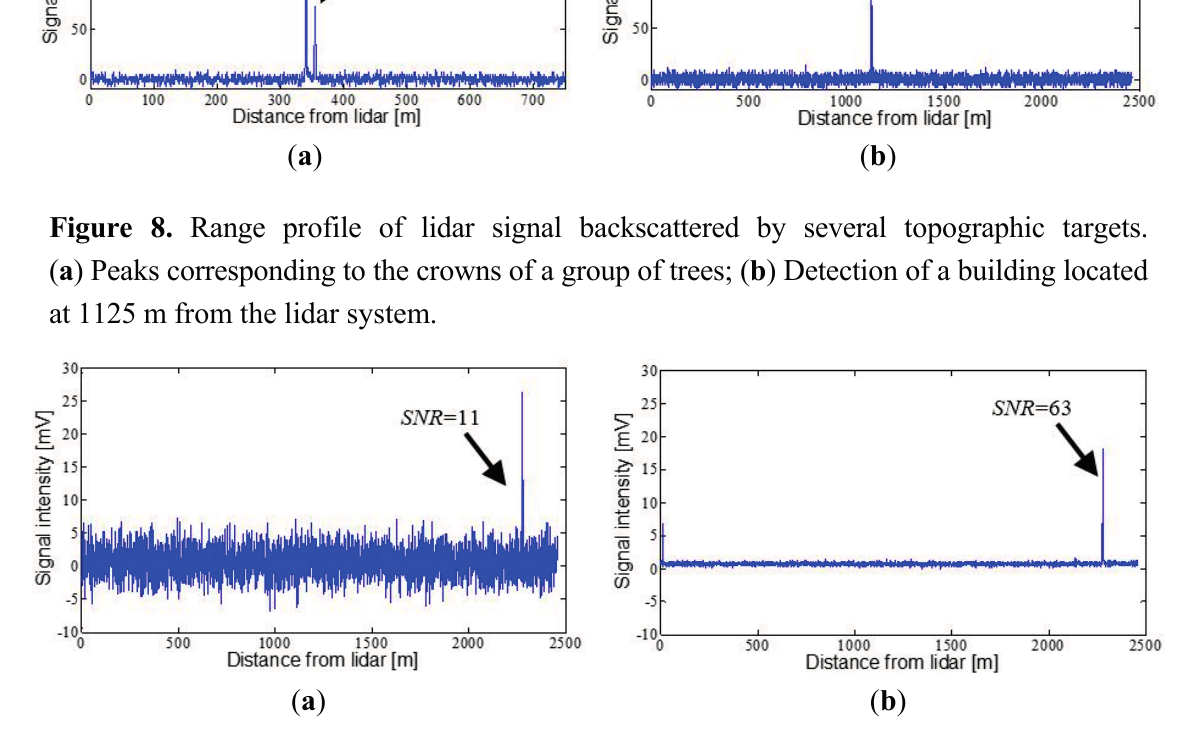
Figure 9. Range profile of lidar signal backscattered by a mountain located at 2275 m from the lidar. ( a ) Return corresponding to a single laser shot; ( b ) Return after averaging 100 laser